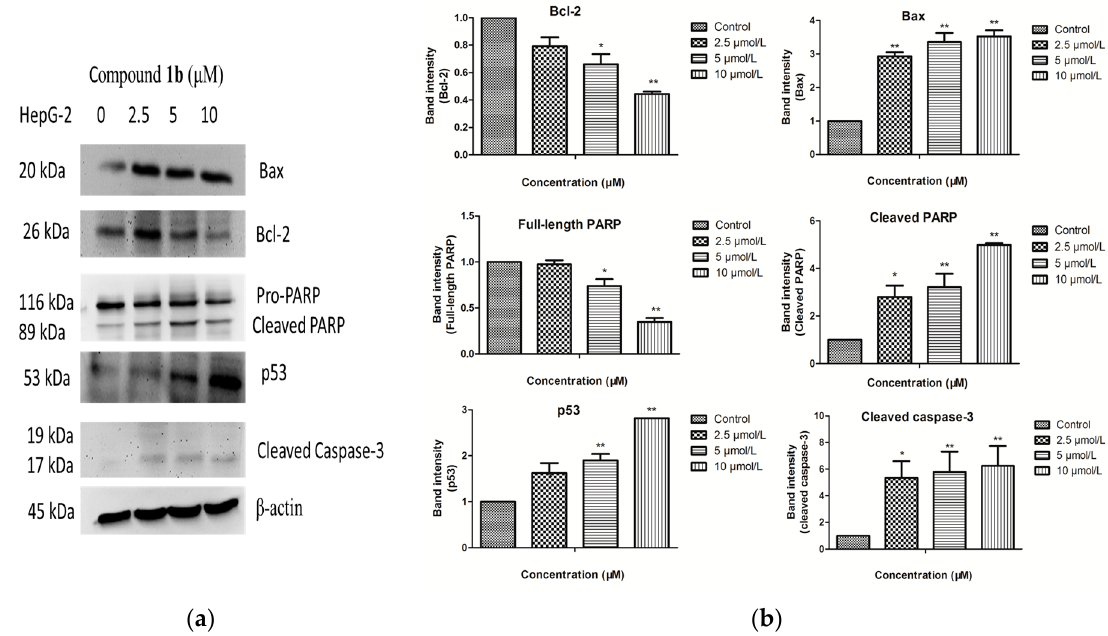
Figure 5. ( a ) HepG-2 cells were treated with compound 1b at the indicated concentrations (0, 2.5, 5 and 10 μ M) for 24 h. The levels of Bcl-2, Bax, PARP, p53 and cleaved caspase-3 were determined by western blot analysis; ( b ) Data are showed as the mean values ± SD from three independent experiments. Data were analyzed by Student’s t-test. * p < 0.05, ** p < 0.01 vs. control cells.